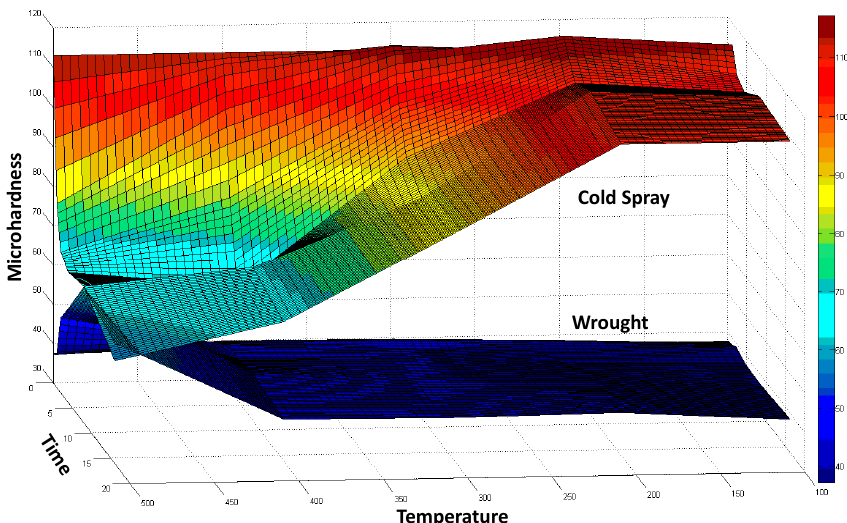
Figure 45. Vickers hardness as a function of heat treatment processing time and temperature for Al 6061 cold spray and Al 6061 wrought materials.